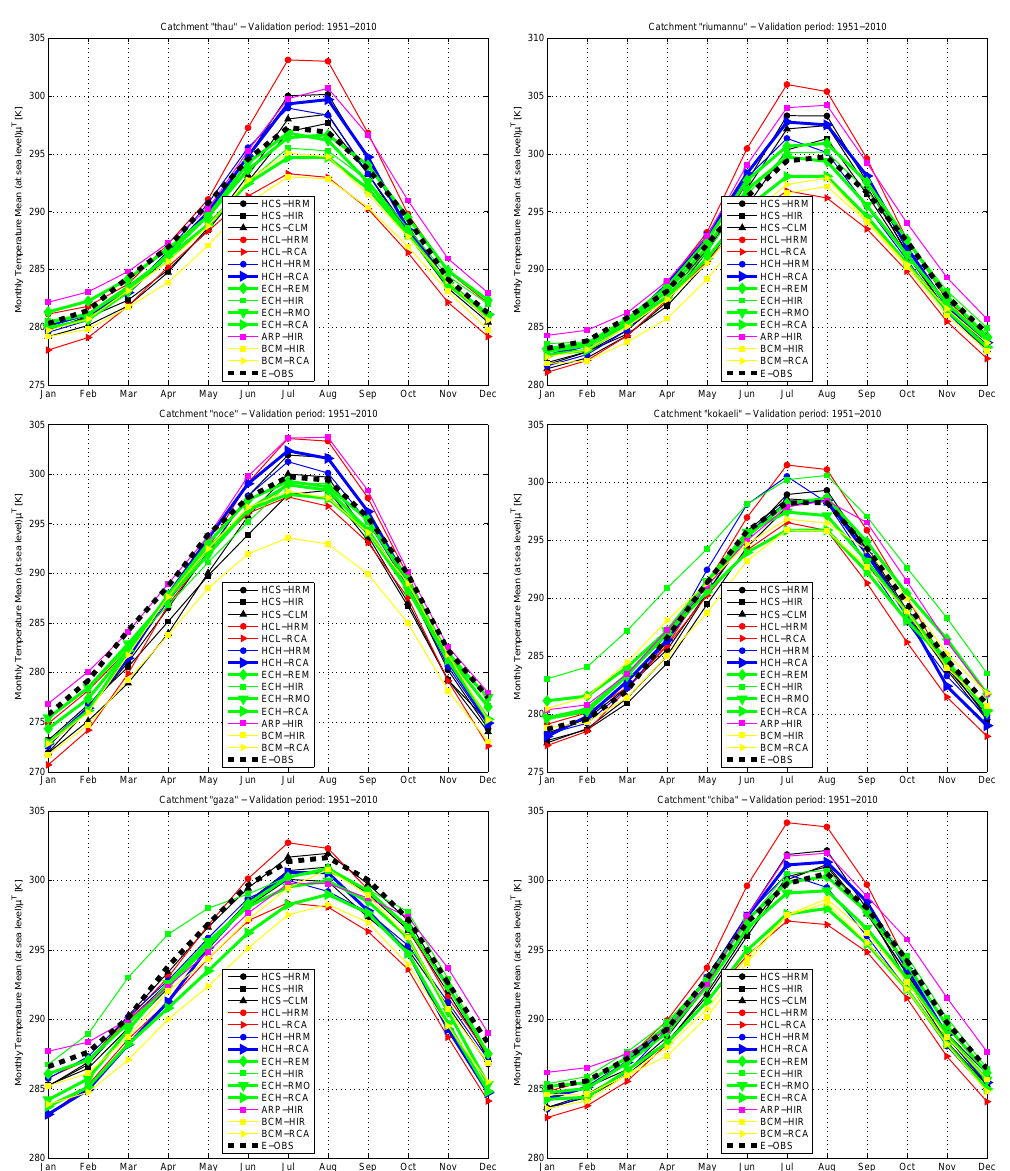
Fig. 4. Same as Fig. 3, but for mean monthly temperatures (K) reduced to sea level.